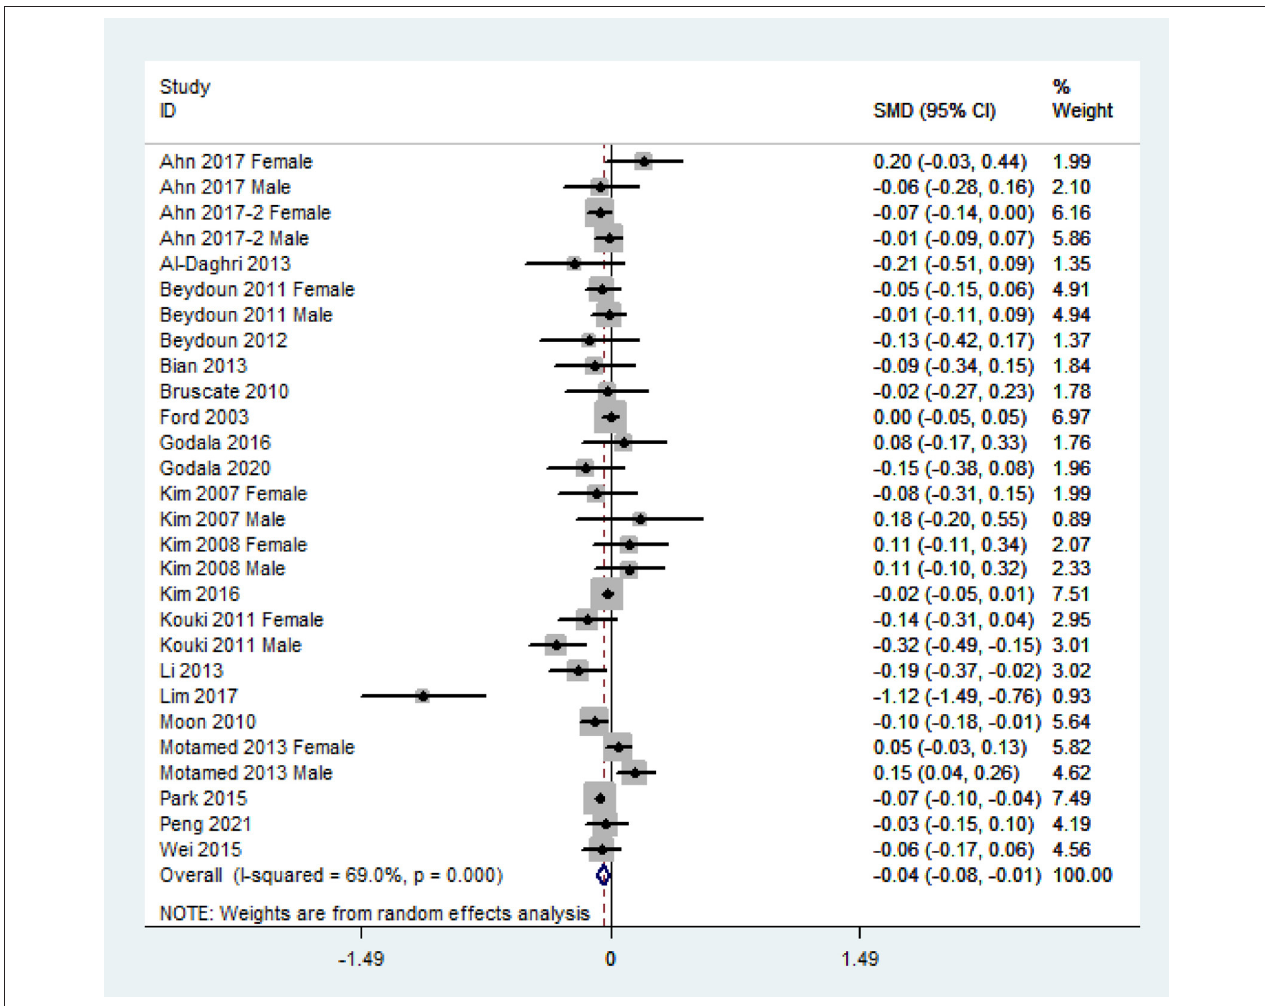
FIGURE 3 | Forest plot of meta-analysis. SMD of dietary vitamin C level for MetS vs. control